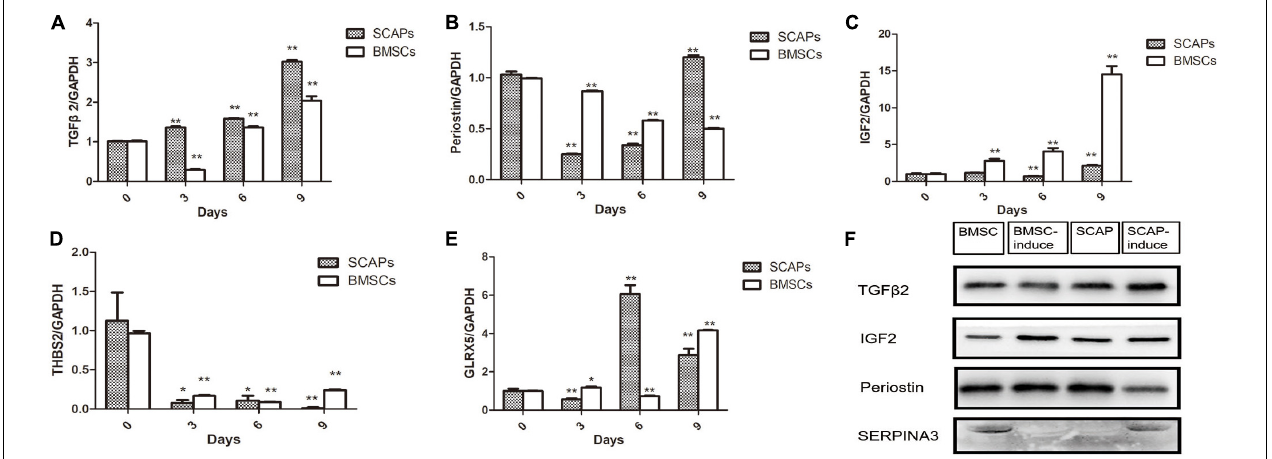
FIGURE 3 | Validation of differentially secreted proteins. (A–E) Real-time reverse transcription polymerase chain reaction (RT-PCR) analysis of TGF β 2, periostin, Thrombospondin-2 (THBS2), IGF2, and glutaredoxin-related protein 5 (GLRX5) expression. PCR expression level is represented as the fold change relative to the levels on day 0. All data are presented as the mean ± SD; * p < 0.05, ** p < 0.01 versus day 0; each experiment was repeated three times. (F) The results of western blotting analysis of TGF β 2, IGF2, periostin, and SERPINA3 were consistent with the findings in our proteomic analysis. TGF β 2 expression was increased after the induction of SCAPs and decreased after the induction of BMSCs at 6